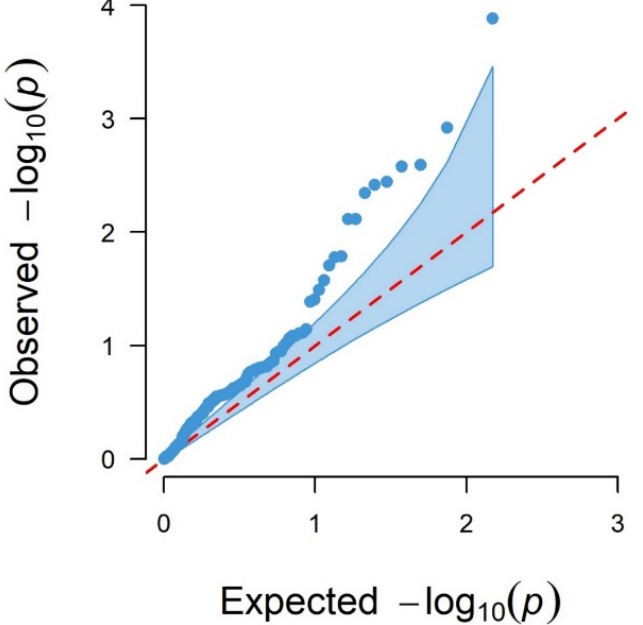
Figure 3. QQ plot of observed − log 10 ( p -values) (blue dots) and expected − log 10 ( p -values) (red dashed line) from GWAS results using the 170 SNPs. In OAR3, one significant SNP is within the TIMP3 gene ( metallopeptidase inhibitor 3 ), and another SNP is in OAR1 in the LEPR gene ( leptin receptor ). Another three SNPs in OAR12 are located within the TLR5 gene ( toll-like receptor 5 ) and two other SNPs in OAR19 are within the TLR9 gene region ( toll-like receptor 9 Table 3. Significant SNPs identified with GWAS for logFEC using 170 SNPs with a chromosome- wise FDR of 5%.